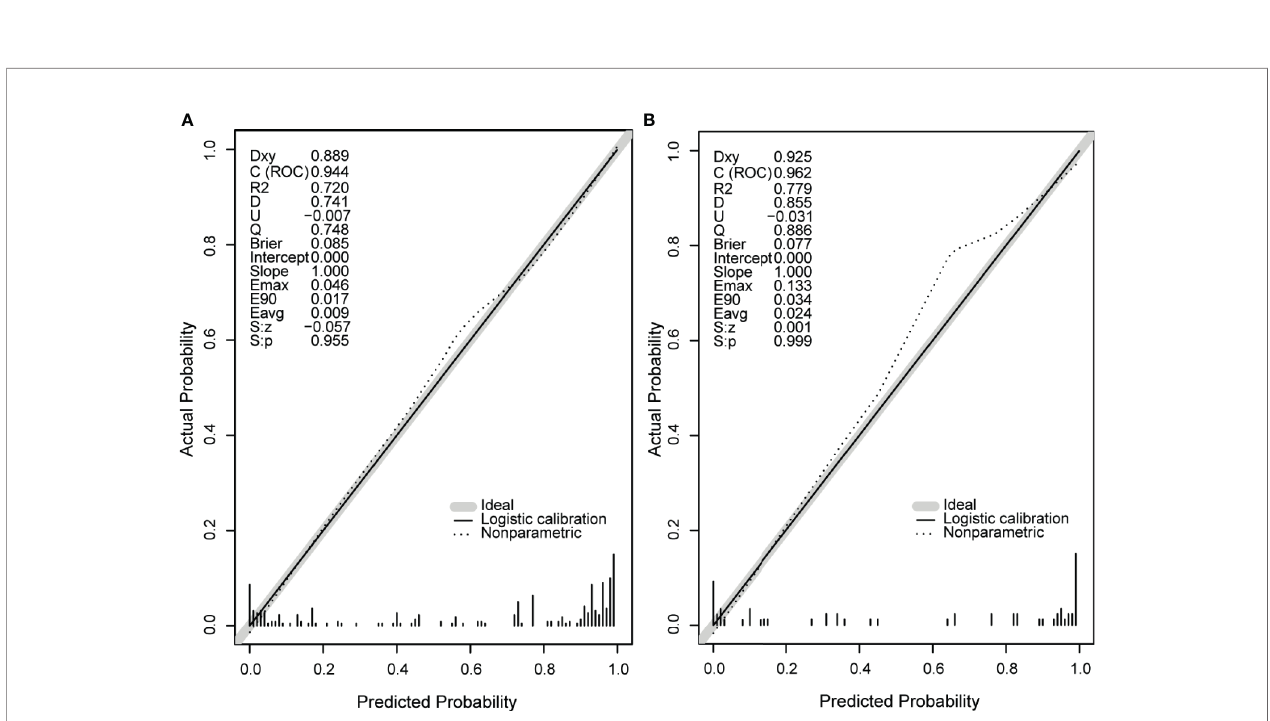
FIGURE 3 | The calibration curve diagrams of the training set (A) and the validation set (B) have good agreement between the predicted probability and the actual probability, both S, p > 0.05. Emax, the maximum offset between the model and the ideal model; Eavg, the minimum offset between the model and the ideal